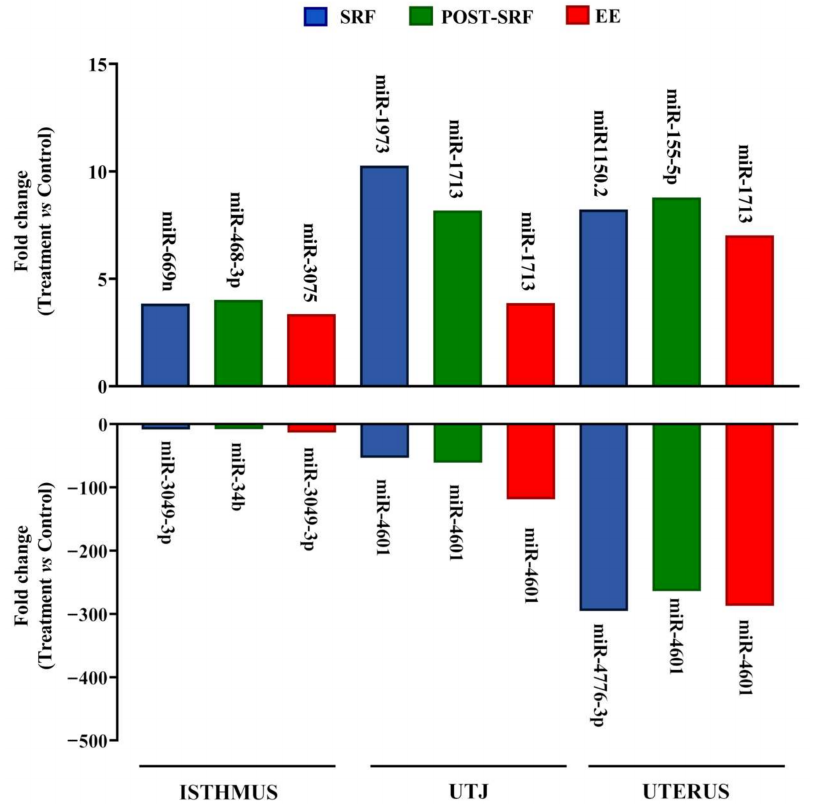
Figure 2. Di ff erentially expressed microRNAs (miRNAs, p -value < 0.05) in culture media from explants (uterus, utero-tubal junction (UTJ) and isthmus) exposed to di ff erent treatment (Medium 199 (M199) supplemented with seminal plasma from di ff erent ejaculate fractions (sperm-rich fraction (SRF) and post-SRF) and the recomposed ejaculate (EE)) compared to controls (M199 alone). Bar chart showing the miRNAs down- and up-regulated in each explant and treatment with the highest and lowest fold change